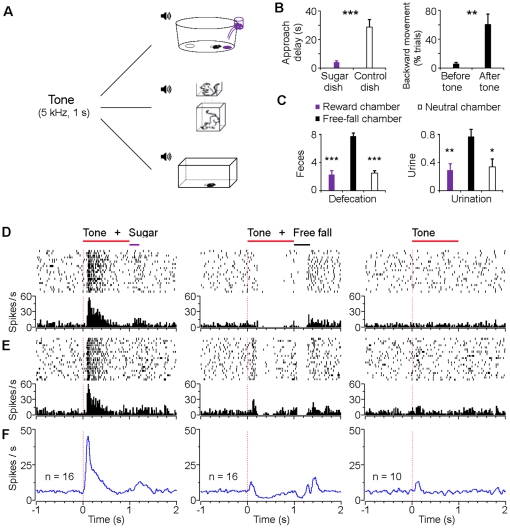
Bi-directional encoding of positive and negative signals via the same conditioned tone in different contexts.(A) Schematic of experimental paradigm for bidirectional conditioning. One tone (5 kHz, 1 sec) was used throughout: it predicted sugar pellet delivery in the reward chamber (top); it predicted free fall event in the free-fall chamber (middle); and it did not predict anything in the neutral chamber (bottom). (B) Left, delay of dish approach after onset of the conditioned tone that predicted sugar delivery. Right, mice showed significant increased backward movement after onset of the conditioned tone that predicted free fall event. (C) Aversion-like behaviors (frequent defecation and urination) elicited in the free-fall chamber compared with the reward or neutral chamber. Error bars, s.e.m.; n = 10; *P<0.05, **P<0.01, ***P<0.001, Student's t-test. (D, E) Peri-event rasters (1–20 trials) and histograms of two examples of VTA putative dopamine neurons in response to the same conditioned tone that predicted sugar pellet delivery (left), that predicted free fall event (middle), and that did not predict anything (right), with an interval of 1–2 h between sessions. (F) Smoothed population average peri-event histograms of fear-suppressed (type-1 and 2) putative dopamine neurons in response to the same conditioned tone that predicted sugar pellet (left panel; n = 16), that predicted free fall event (middle panel; the same 16 neurons as shown in the left panel), and that did not predict anything (right panel; n = 10). Free fall, 30 cm high.